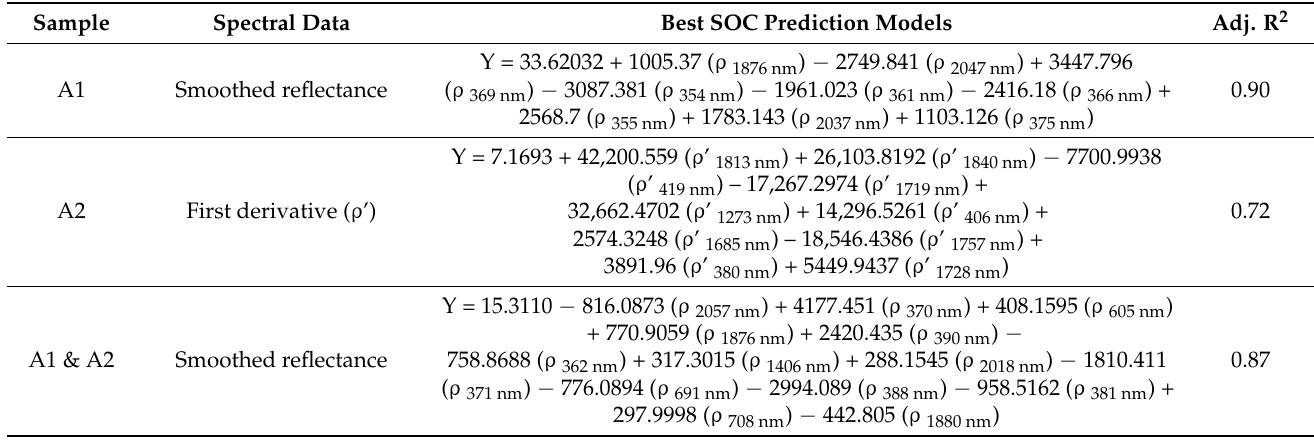
Table 6. Equations for SOC prediction (g kg − 1 ) with the best models constructed using PCR for each sample subset, including the respective adjusted R 2 .